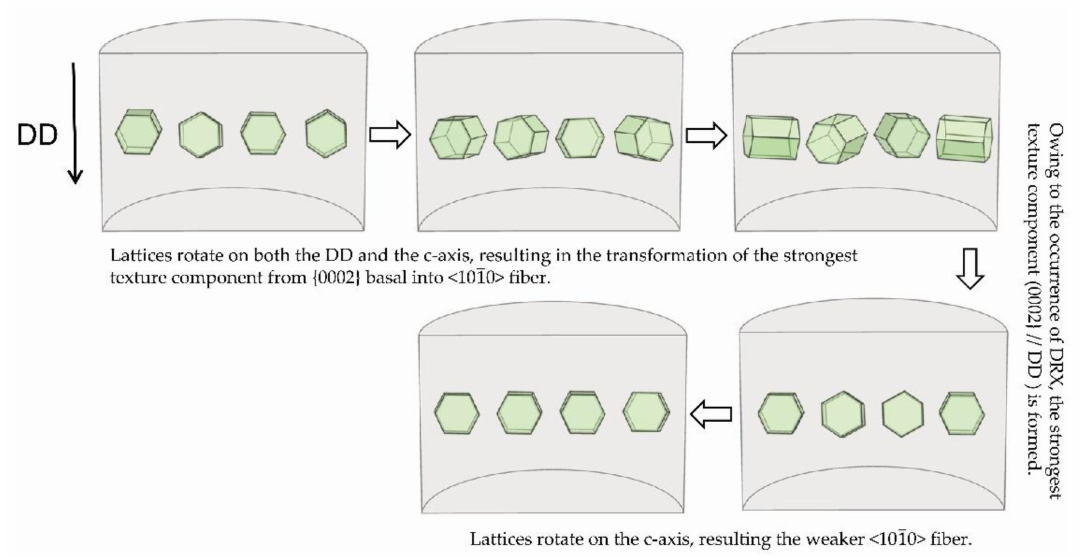
Figure 6. Schematic drawing of lattice rotation in the process of pure Mg cold